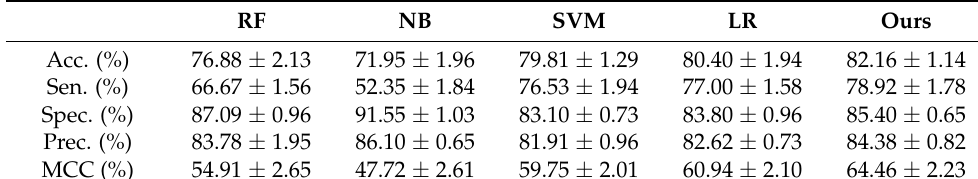
Table 5. The performance of the proposed method in SM2miR datasets.